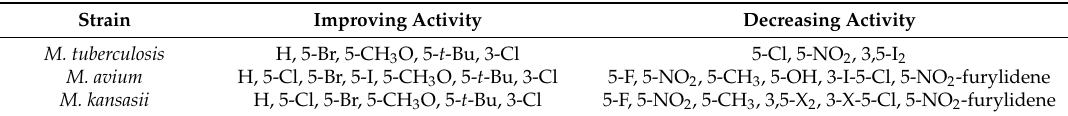
Table 4. SAR for the antimycobacterial